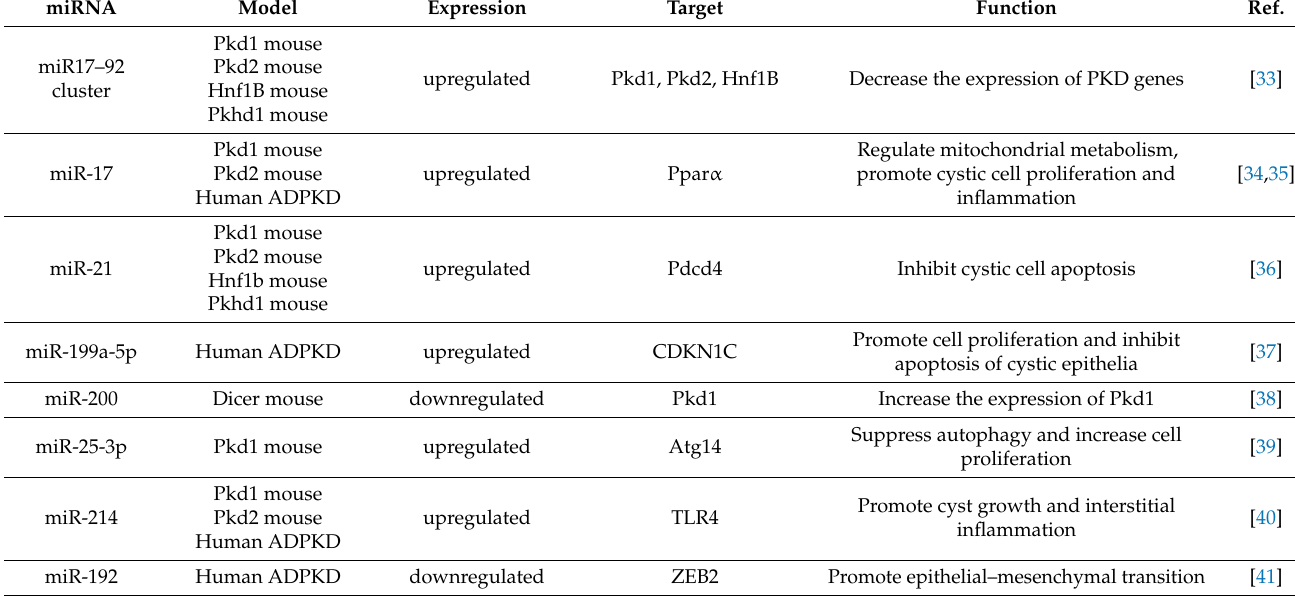
Table 2. MicroRNAs that are involved in